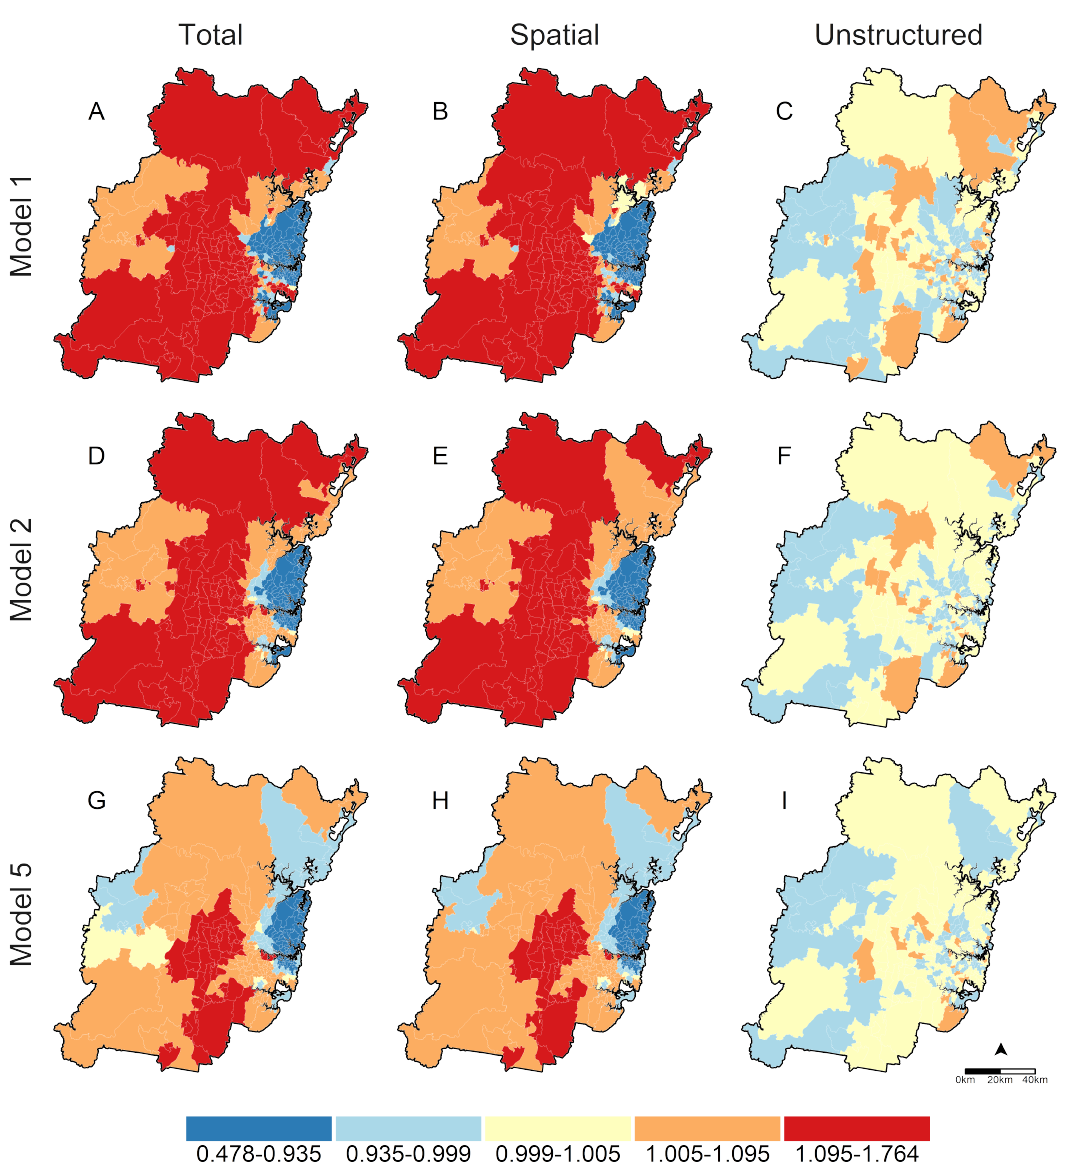
Figure 2. Total, Spatial and Unstructured prevalence ratios for obese body mass in Sydney postal areas. Total prevalence ratios are derived by exponentiating the sum of spatial ( s ) and unstructured ( u ) random effects; Spatial and Unstructured prevalence ratios are obtained by exponentiating individual s and u components, respectively. Total, Spatial, and Unstructured prevalence ratio estimates are reported in maps ( A – C ) for Model 1, maps ( D – F ) for Model 2, and maps ( G – I ) for Model